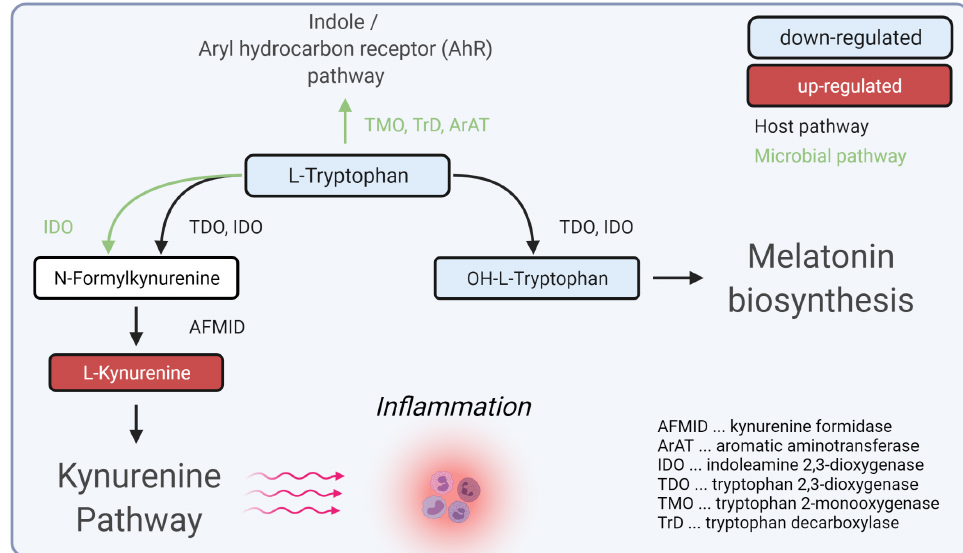
Figure 4. Hypotheses for the role of dysregulated tryptophan/kynurenine pathway during inflam- mation in SSc. Created with BioRender.com (accessed on 31 December 2021).